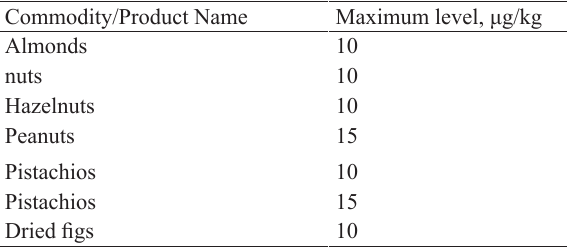
Table 2 Permissible level of aflatoxins in nuts in GCC